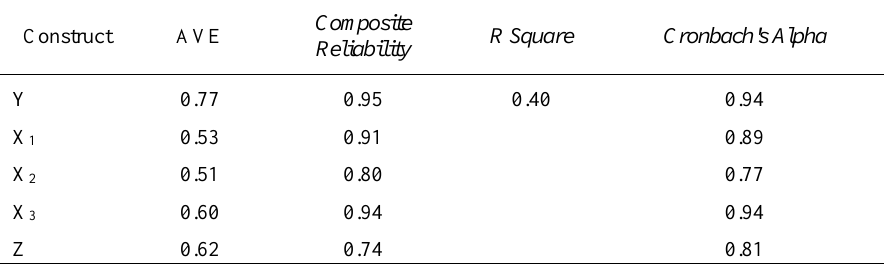
Table 3: Result of Validity and Reliability Test